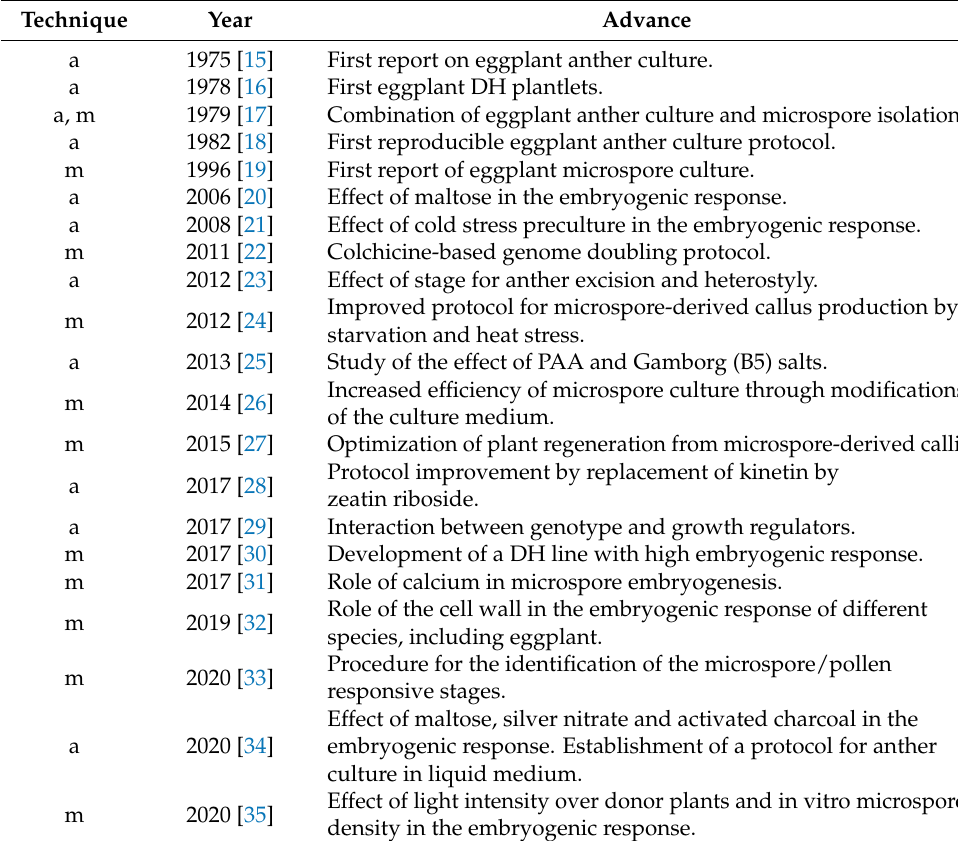
Table 2. Chronological advances in the protocol for eggplant DH production through anther and isolated microspore culture. a: anther culture, m: microspore